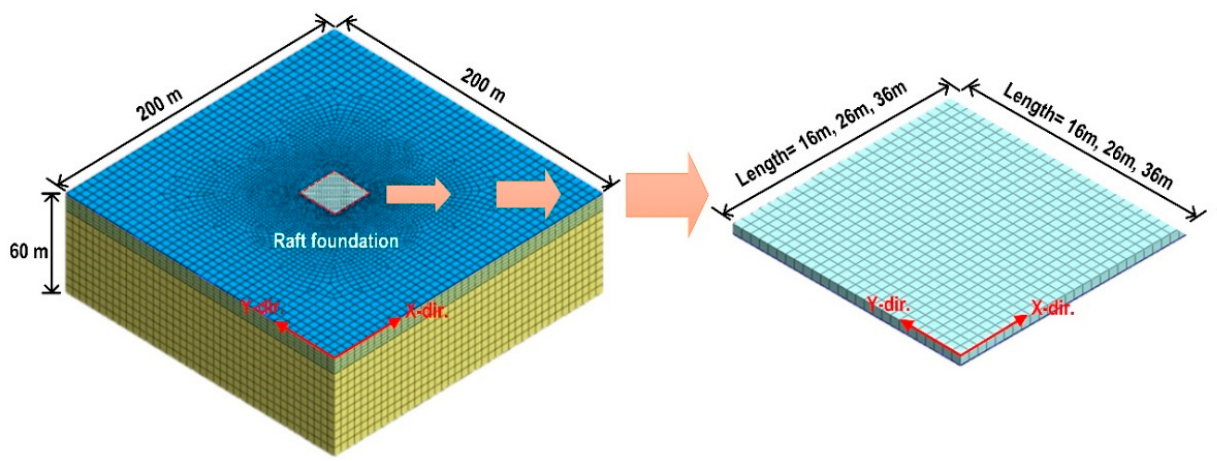
Figure 2. FE mesh used in this study.